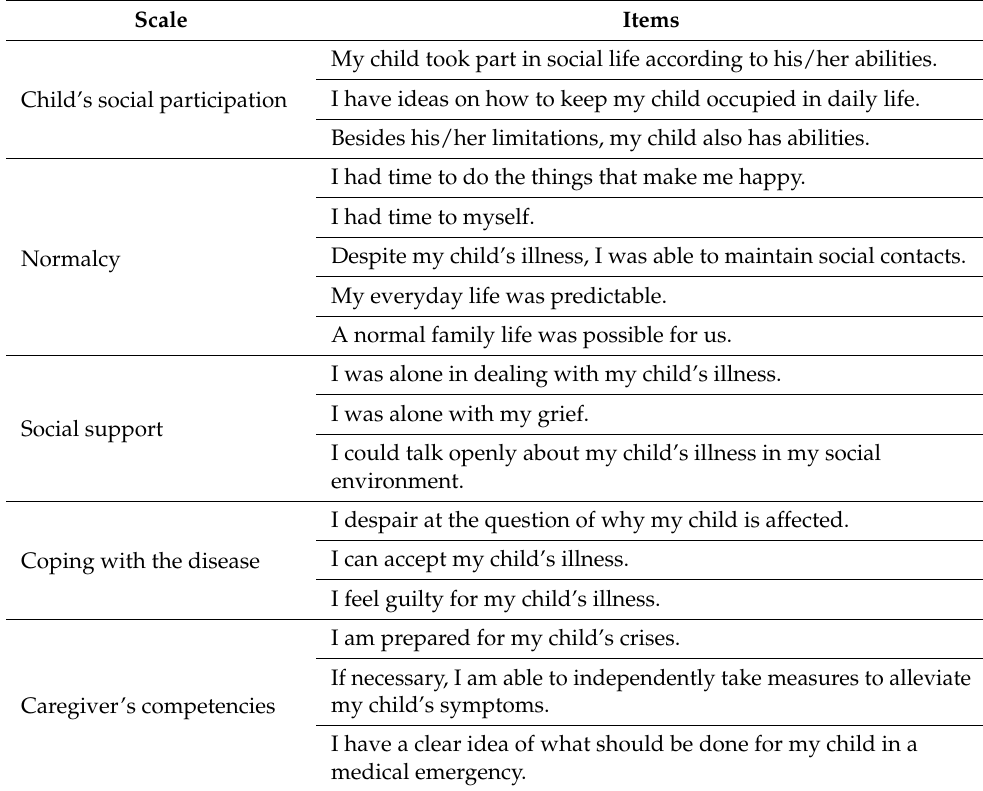
Table 4. Questionnaire scales and their respective items. Scale